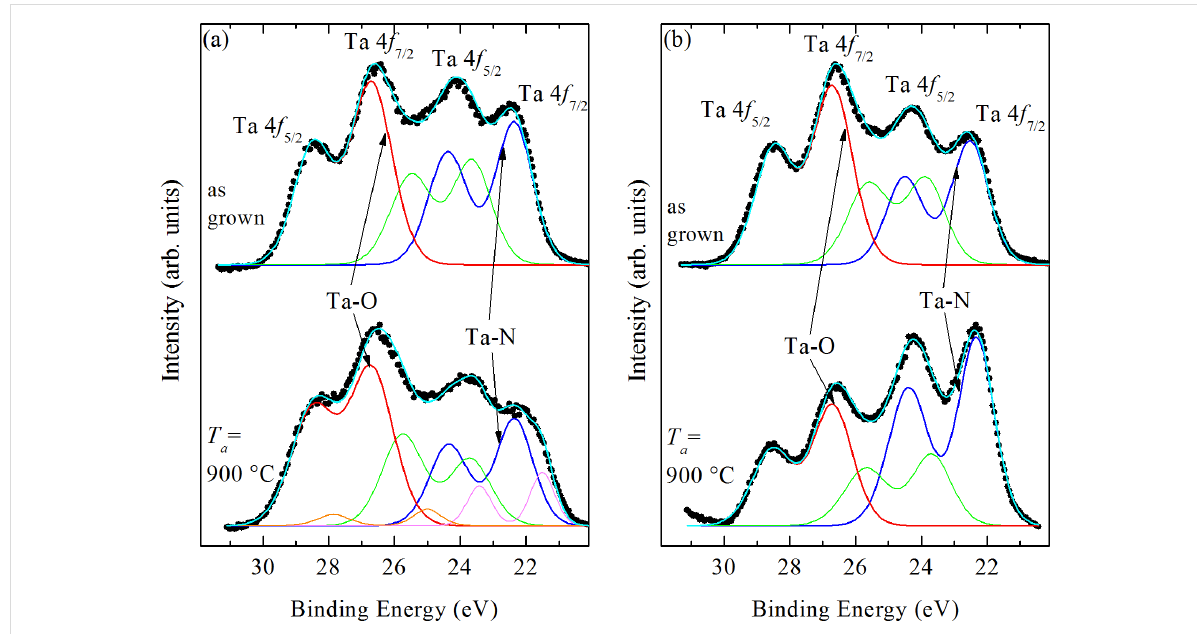
Figure 5: Deconvoluted XPS spectra for Ta 4f core level of as-grown (upper curves) and annealed at 900 °C (lower curves) MLs for two different nominal thicknesses of the metallic layers: (a) 4 nm (b) 12 nm.